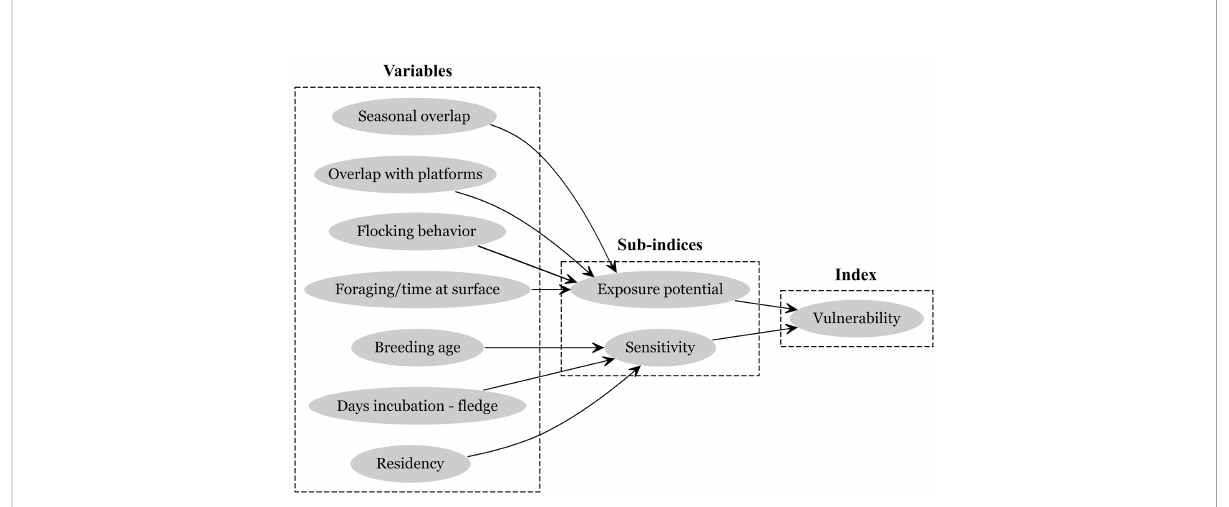
FIGURE 1 The relationship among species-speci fi c variables, environmental variables, and sub-indices pertaining to the vulnerability of seabirds to oiling index (VSOI). Each variable receives a score based on the impact that interaction with oil is likely to have on that variable. For variable de fi nitions, scoring, and index calculation, see below and Table